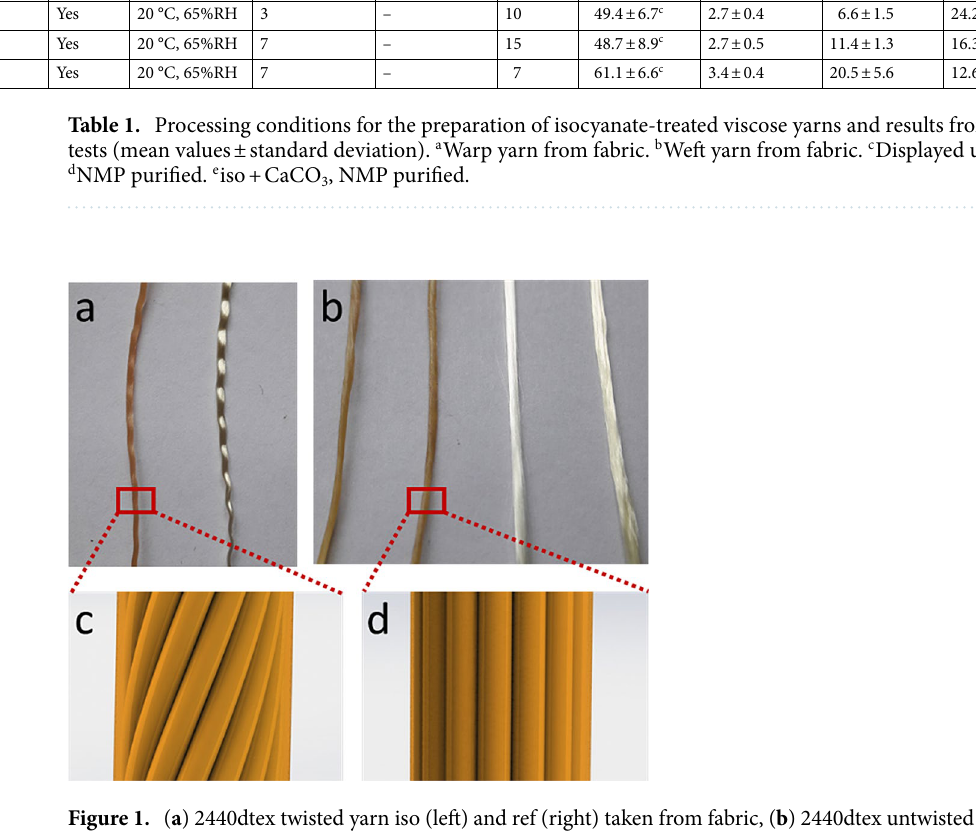
Figure 1. ( a ) 2440dtex twisted yarn iso (left) and ref (right) taken from fabric, ( b ) 2440dtex untwisted iso without avivage, iso with avivage, ref without avivage, ref with avivage (left to right), ( c ) schematic (!) of twisted, treated yarn ( d ) schematic (!) of untwisted treated yarn. Image c and d were drawn in SOLIDWORKS® 2019 SP3.0. Software available at https:// www. solid works.